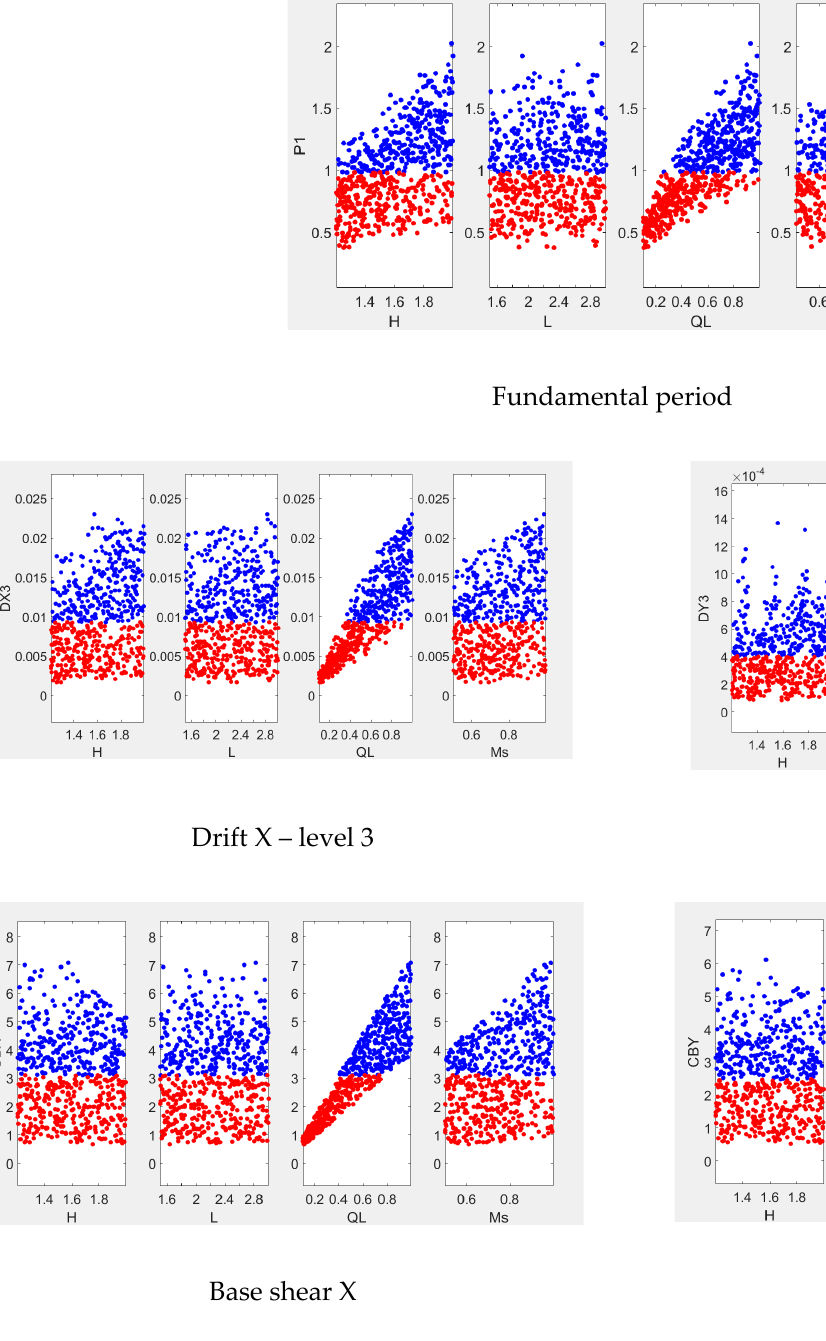
Figure 10. Results of sensitivity analysis for CBZ2S4 models without bracing towers racks models.